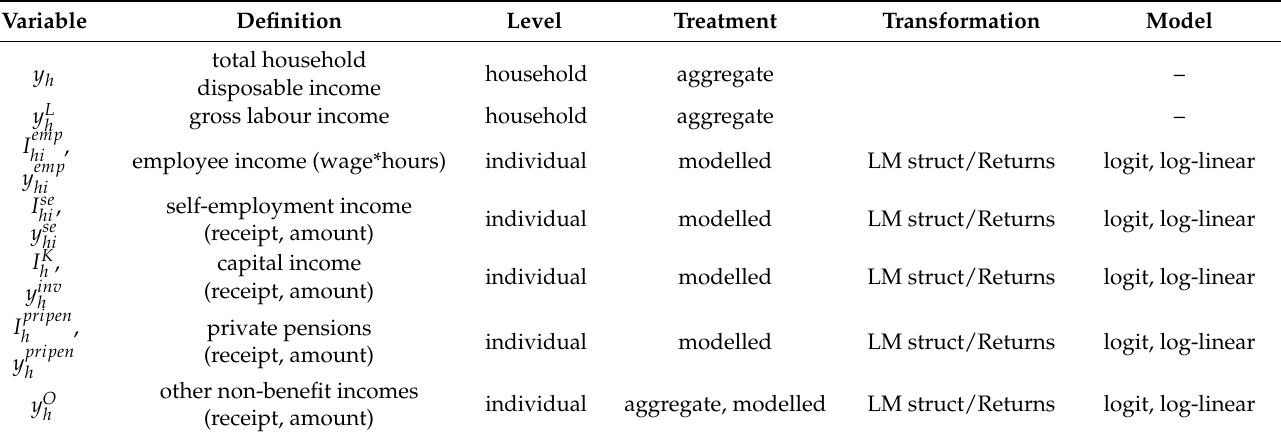
Table A1. Definition of income components and summary modelling